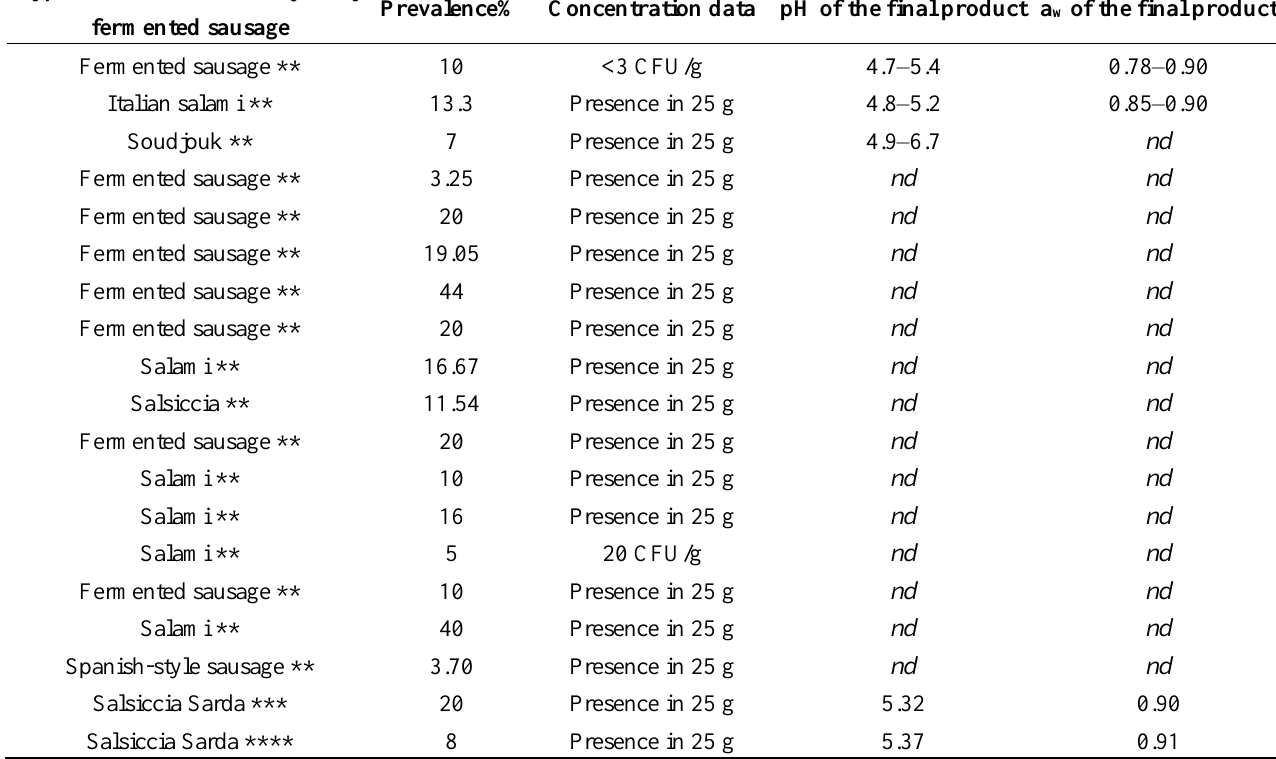
Table 2. Prevalence of Listeria monocytogenes in naturally-contaminated Mediterranean-style dry fermented sausages